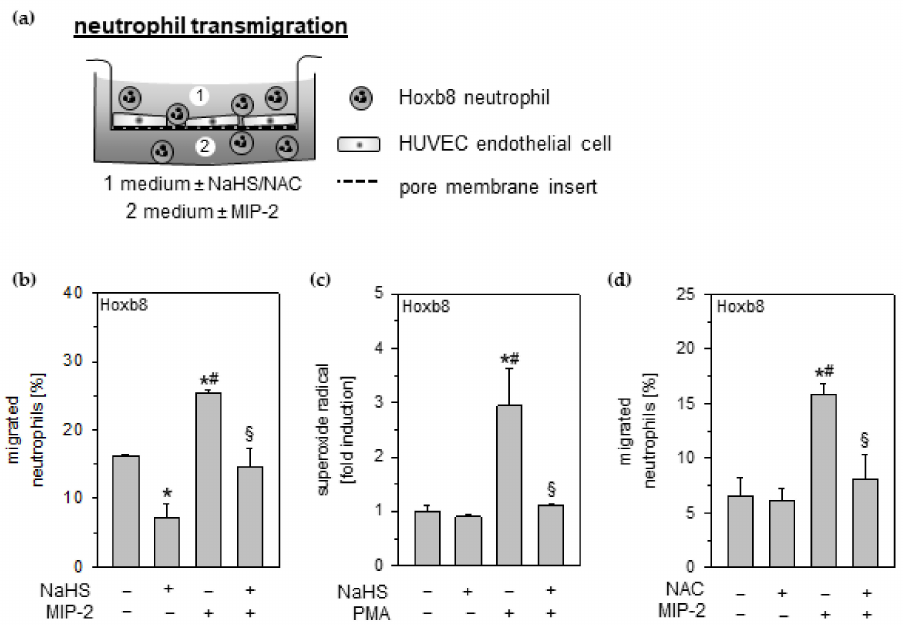
Figure 5. Effects of hydrogen sulfide and radical scavenging on neutrophil transmigration through the endothelial monolayer. ( a ) Co-culture setup of Hoxb8 neutrophil migration experiments. ( b )